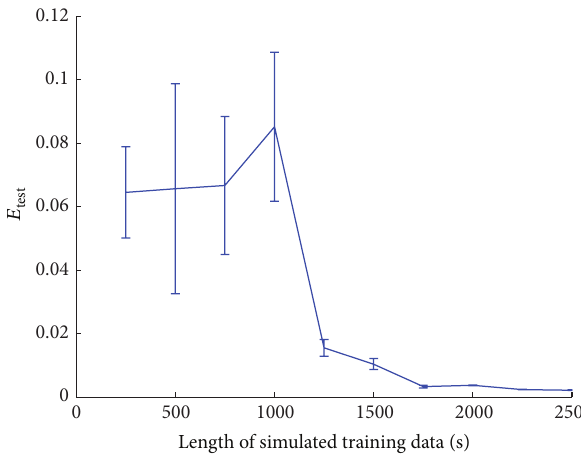
Figure 8: Validation error as function of amount of training data.